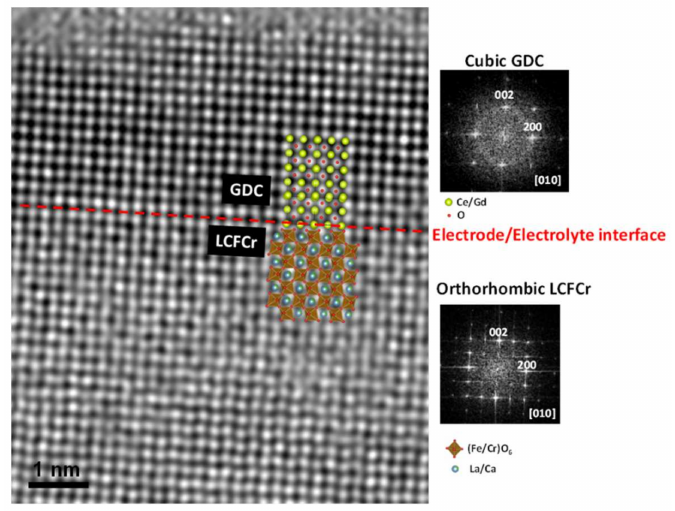
Figure 9. HRTEM image of the electrode (LCFCr)/electrolyte (GDC) interface in a 2-electrode LCFCr-based cell after long-term electrochemical testing for 200 h. On the right side, the optical diffraction patterns, obtained from both sides of the interface, are identified as cubic GDC and orthorhombic